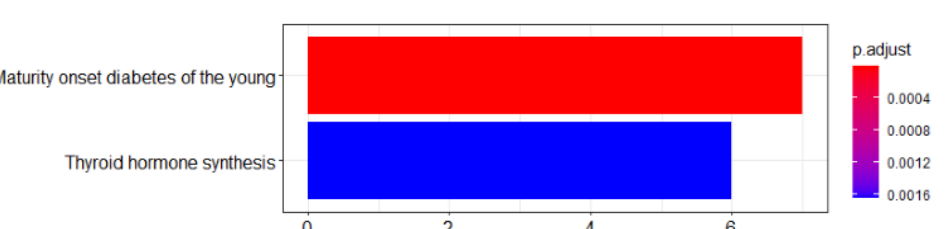
Figure 10. The GO and KEGG pathway enrichment analysis of 196 obtained gene.